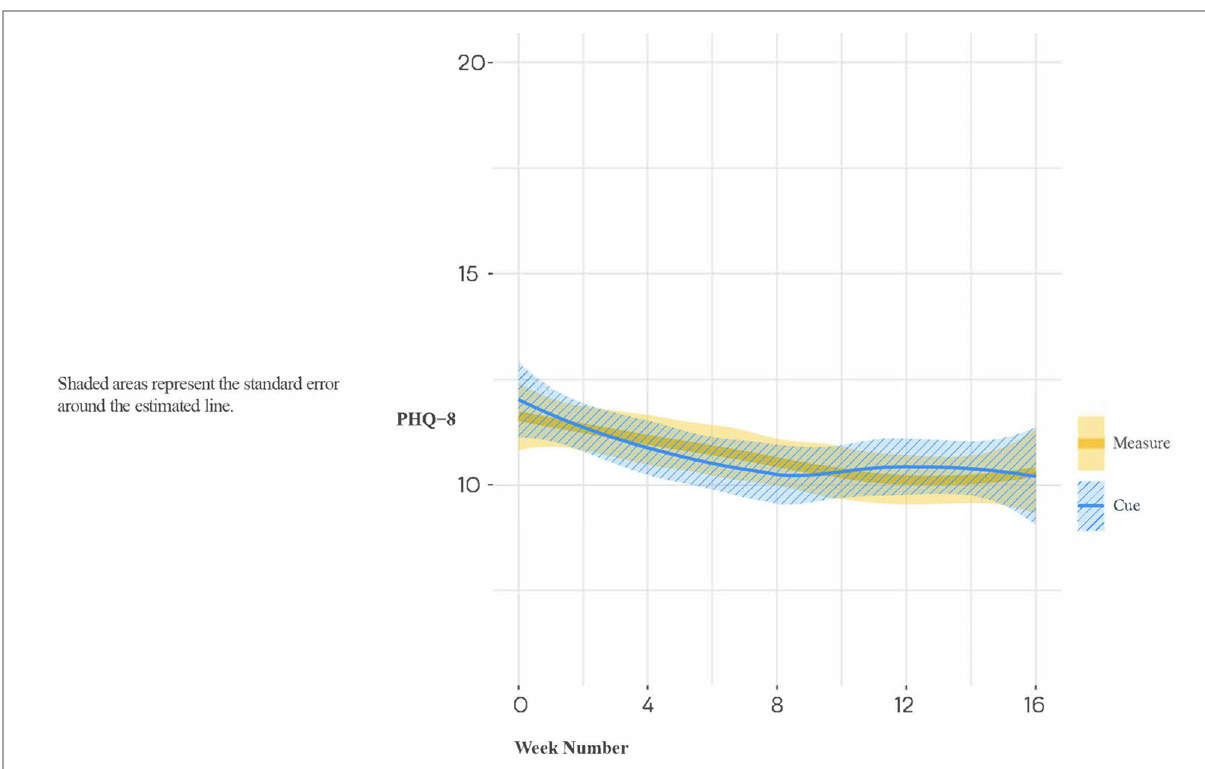
FIGURE 5 Loess trajectories of PHQ-8 for Cue and measure (control) conditions in full study